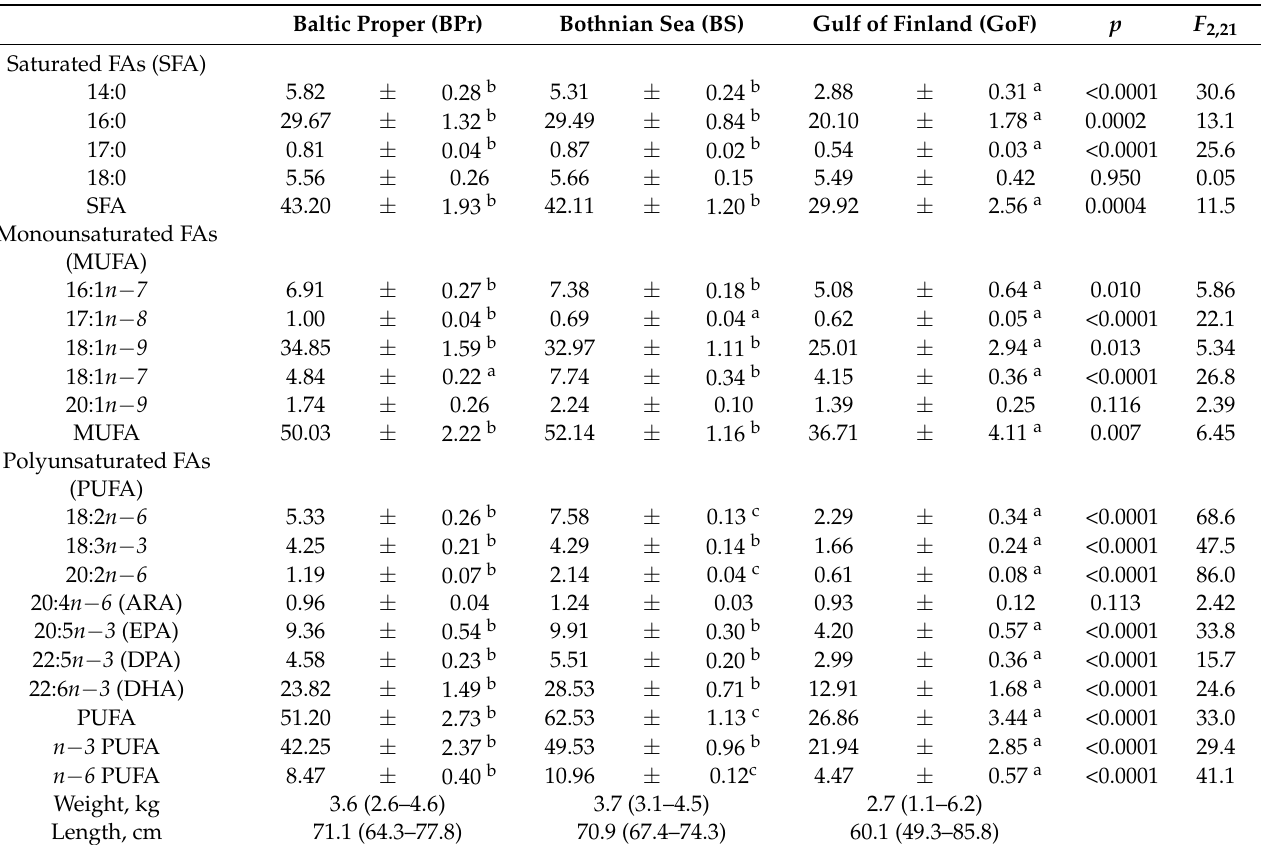
Table 1. Mean ( ± SE) concentrations (i.e., lipid-weighed proportions) of fatty acids (FAs, mg g − 1 ), their structural classes, and some of their ratios in salmon ( Salmo salar ) from the Baltic Proper (BPr, N = 9), Bothnian Sea (BS, N = 5), and Gulf of Finland (GoF, N = 10). The mean weight and length with the ranges are also